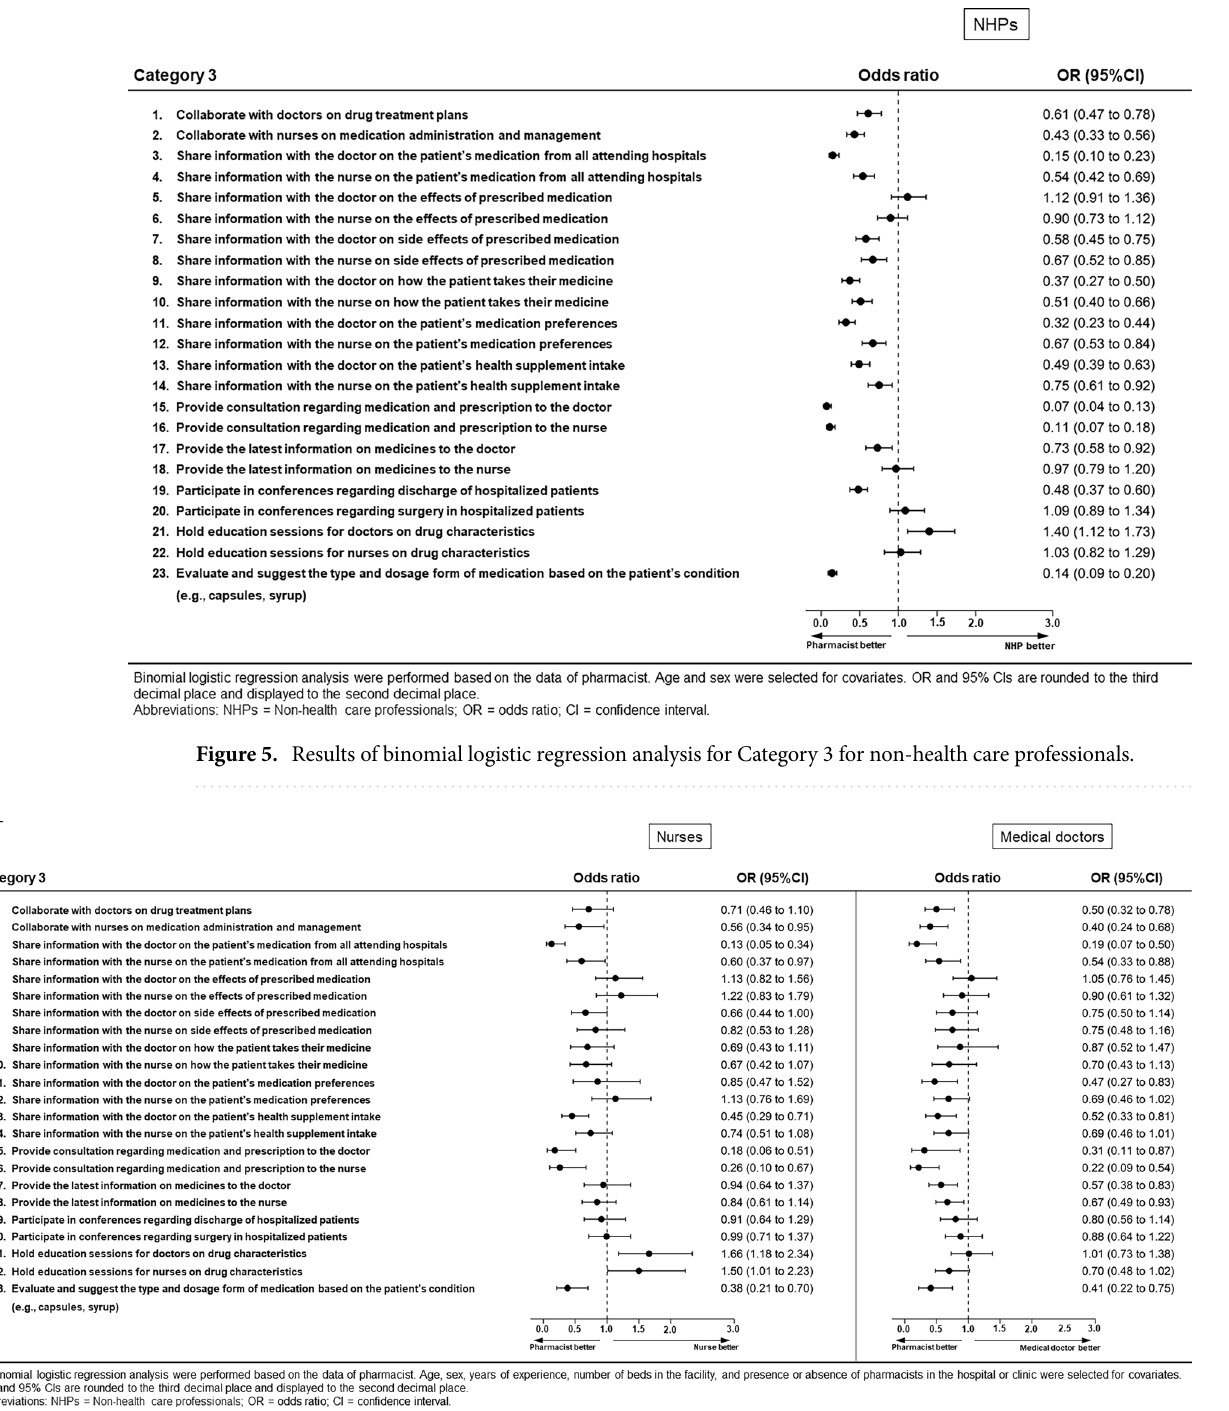
Figure 6. Results of multinomial logistic regression analysis for Category 3 for nurses or